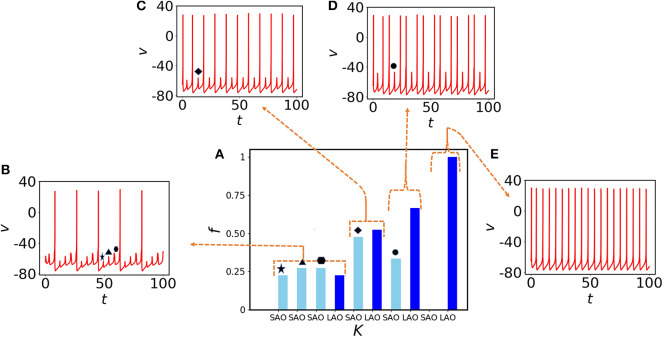
Impact of coupling K on MMOs of a quiescent (red) node. (A) Probability distribution of spikes in SAOs (light blue) and LAOs (deep blue) for K = 0.3, 0.4, 0.6, and 1 from left to right, respectively. (B) The time evolution for K = 0.3. Three small amplitude oscillations (star, triangle, and hexagon) appear between two consecutive large amplitude spikes. (C) One small amplitude spike (diamond) appears between two large amplitude spikes at K = 0.4. (D) One small amplitude spike (black circle) appears after two spikes emerging together for K = 0.6. Therefore, the probability of small amplitude spikes is decreased [third part of (A)] and results to the emergence of MMBOs. (E) Small spikes vanish at higher coupling (K = 1), therefore MMOs are lost and tonic spikes are generated, instead.